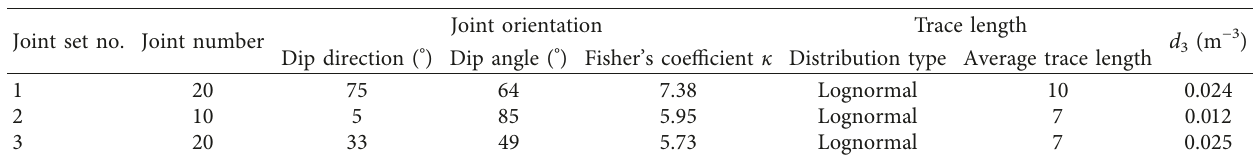
Figure 10: Zipingpu hydropower station in Sichuan, China. Table 9: Joint data of the dam rock mass.